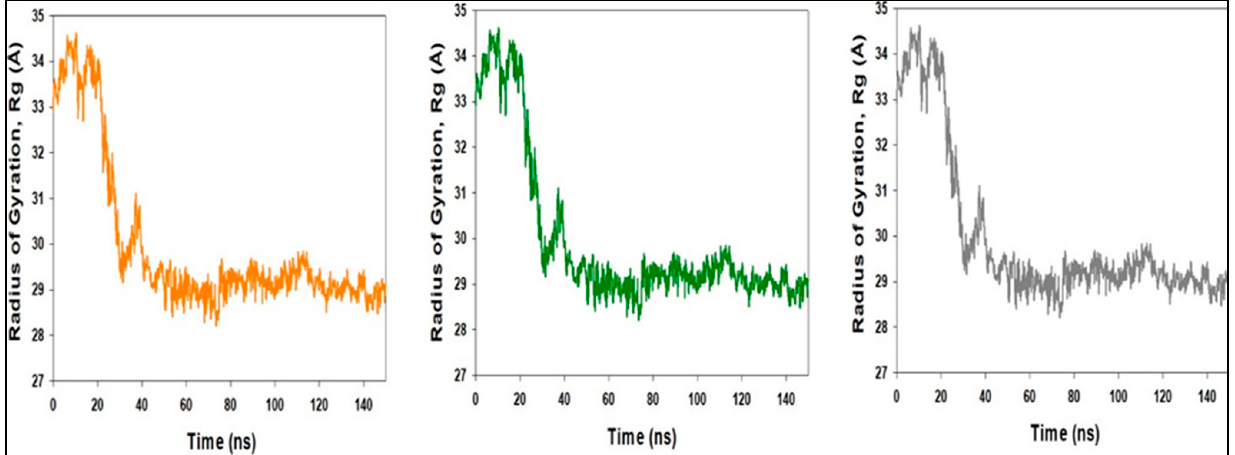
Figure 18. MD simulation trajectory analysis of Radius of Gyration (RoG) of compound 1 bound with LSD with their triplicate runs.